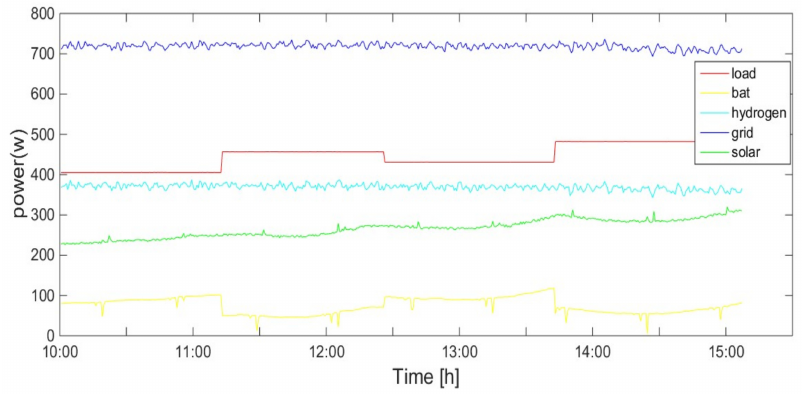
Figure 19. Power curves in scenario 6.